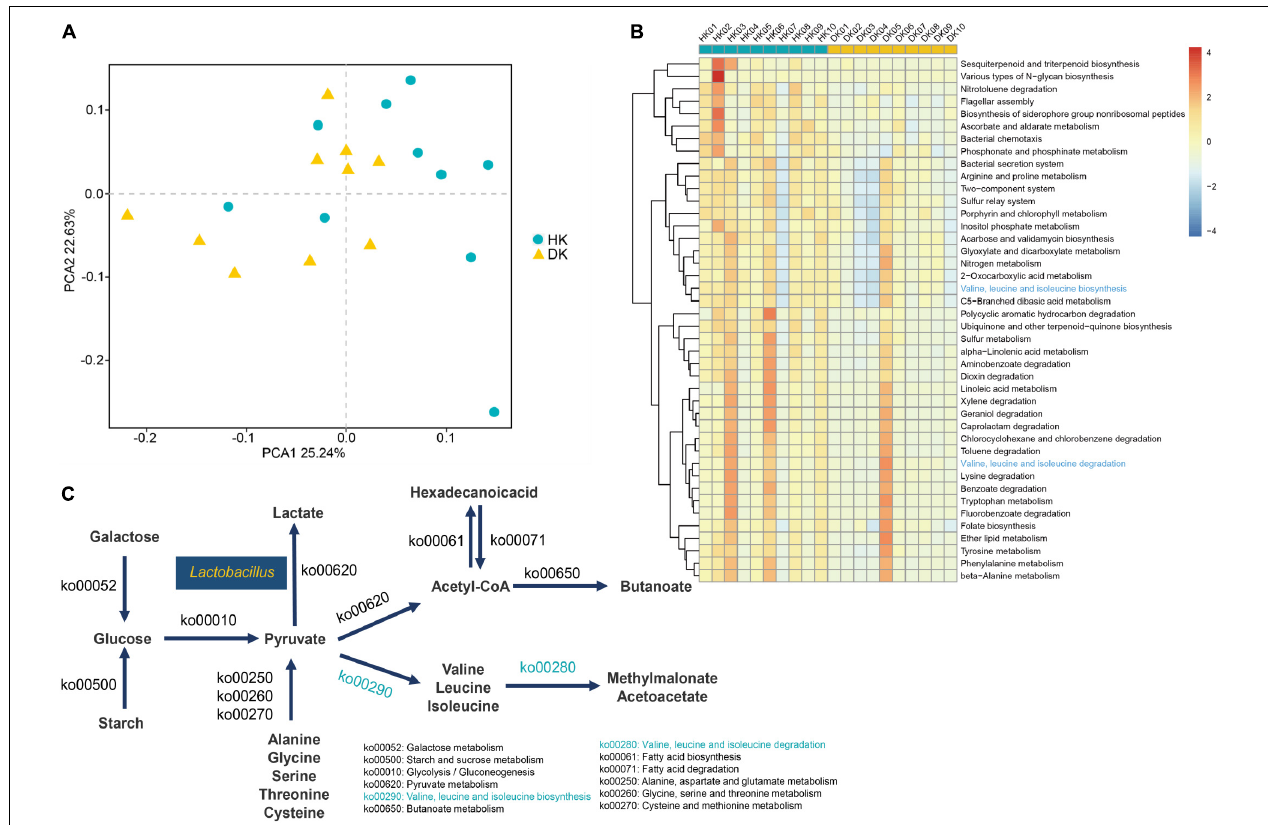
FIGURE 4 | (A) PCoA used binary Jaccard distances, and the distance on the coordinate diagram indicates the similarity of functional composition between samples. (B) Hierarchical clustering of functional genes whose P -values < 0.05 after the rank-sum test. The different KEGG pathways in level 3. (C) Microbial functions and species involved in carbohydrate metabolism and amino acid metabolism in fecal of goat kids, and yellow means increased in the DK group, and blue means increased in the HK